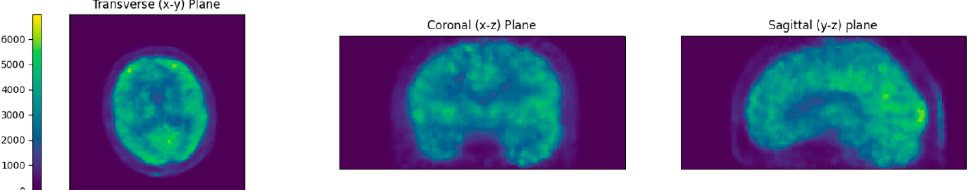
Figure 10. Slices through the reconstructed image for patient P3 with template T2. When compared to the reconstructions in Figure 8, it becomes evident that the slightly lower correlation coefficient 0.8 does not indicate a lower image quality. Table 1. Summary of linear regression results for comparison of BPET reconstructions with reference PET. The linear regression is given as a line equation with slope × x + intercept. The “correct µ” column shows the results with the µ-map obtained from the CT of the patient that was imaged.